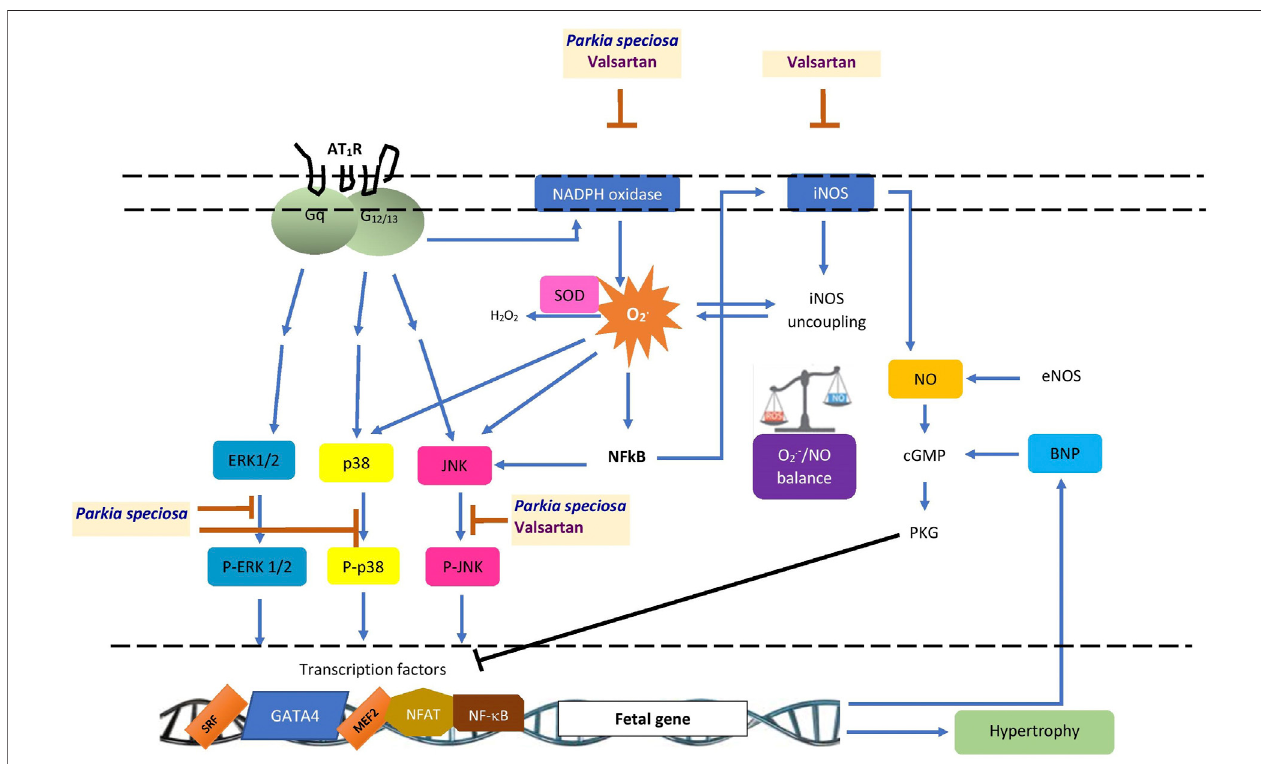
FIGURE 11 | Schematic summary of the possible site of cardioprotective effects of Parkia speciosa empty pod extract. AT 1 R, angiotensin II type 1 receptor; BNP, B-type natriuretic peptide; cGMP, cyclic guanosine monophosphate; eNOS, endothelial nitric oxide synthase; ERK1/2, extracellular signal-related kinase; iNOS, inducible nitric oxide synthase; JNK, c-Jun N-terminal kinase; MEF2, myocyte enhancer factor-2; NFAT, nuclear factor of activated T-cells; NF- κ B, nuclear factor kappa B;NO,nitricoxide;PKG,proteinkinaseG;p38,p38kinase;P-ERK1/2,phosphorylatedextracellularsignal-relatedkinase(ERK1/2),P-JNK,phosphorylatedc-Jun N-terminal kinase; P-p38, phosphorylated p38 kinase; SOD, superoxide dismutase; SRF, serum response factor; ⊥ , inhibition.